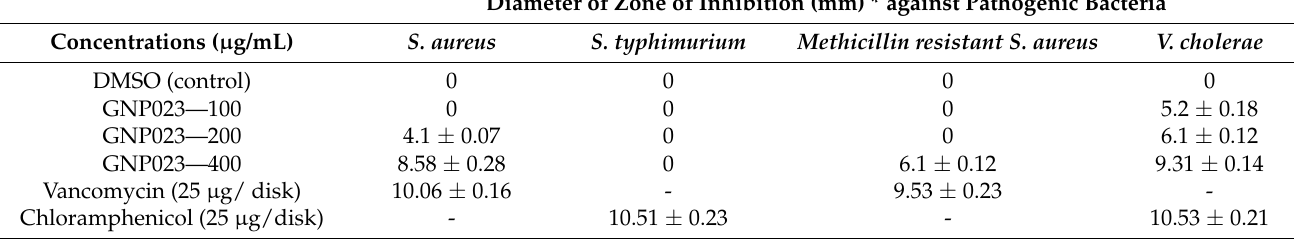
Table 2. Antimicrobial activity of gold nanoparticle GNP023. Diameter of Zone of Inhibition (mm) * against Pathogenic Bacteria Concentrations ( µ